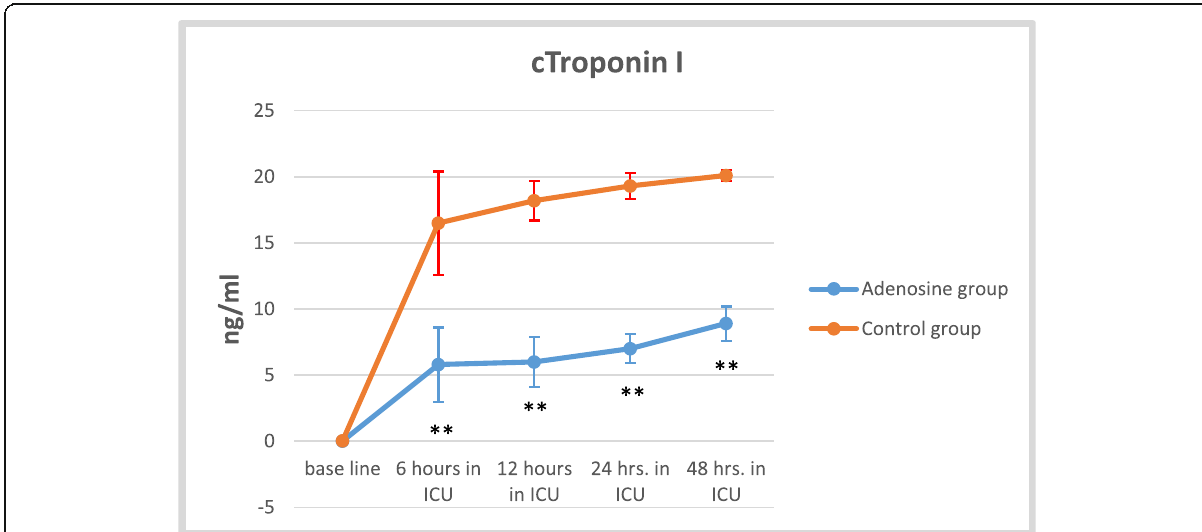
Fig. 9 Effect of adenosine on cTroponin I. Data were presented as mean ± SD. ** p value is highly